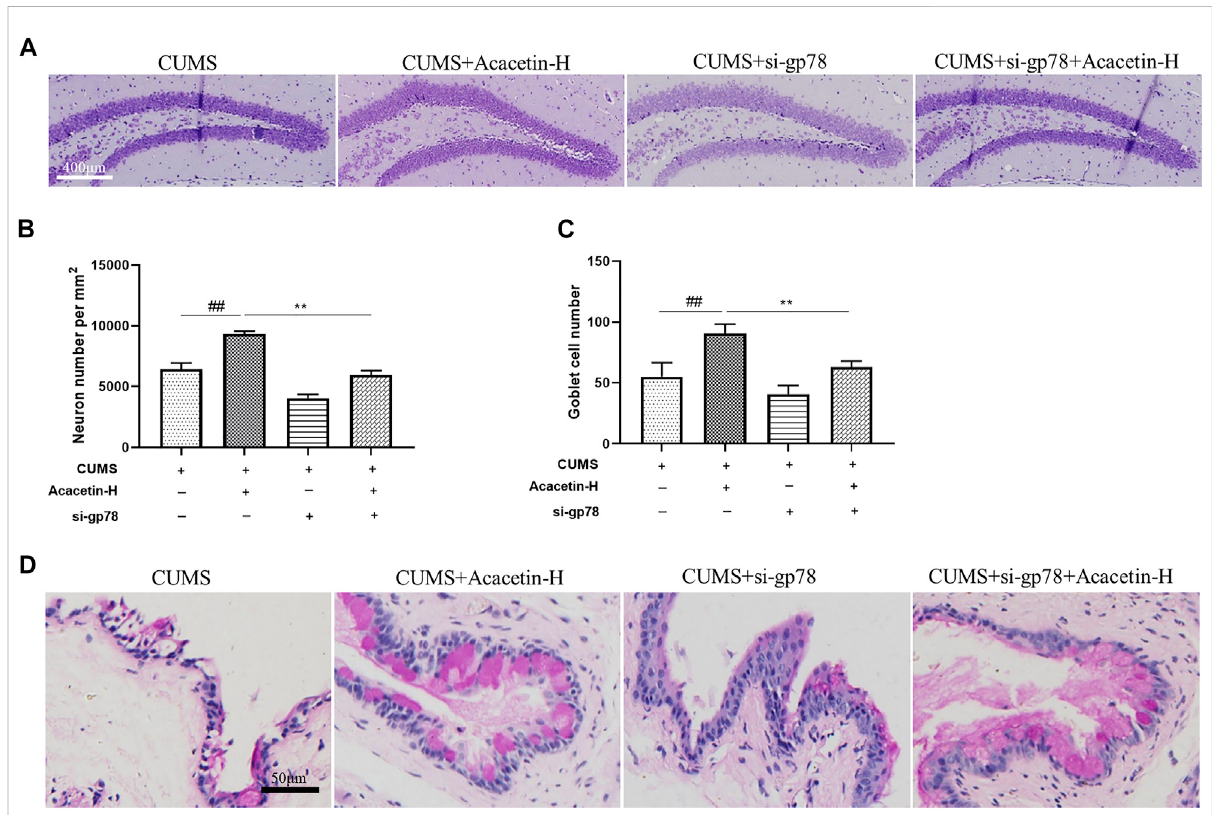
FIGURE 8 In fl uence of gp78 siRNAs on hippocampus Nissl bodies and goblet cells in CUMS mice. (A – B) Representative images of Nissl staining and quantitative analysis of Nissl bodies in the hippocampus. (C – D) Representative images of PAS staining and quantitative analysis of goblet cells in the cornea. Results are expressed as the mean ± SEM ( n =3 per